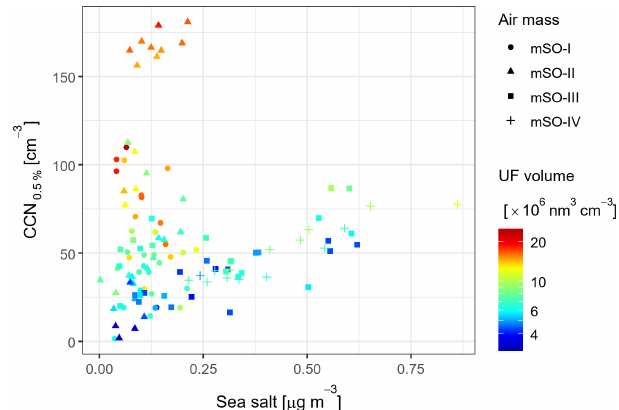
Figure 5. Correlations between non-accumulation mode CCN 0 . 5% and sea salt mass concentrations derived from ACSM measure- ments. The point shapes represent the four periods affected by ma- rine air masses, while the colour scale represents the corresponding volume concentrations of ultrafine aerosol. Pearson’s correlation coefficients (and p values) were 0.169 (0.30), 0.495 (3 . 4 × 10 − 3 ), 0.516 (1 . 5 × 10 − 3 ), and 0.929 (5 . 6 × 10 − 7 ) for each air mass in chronological